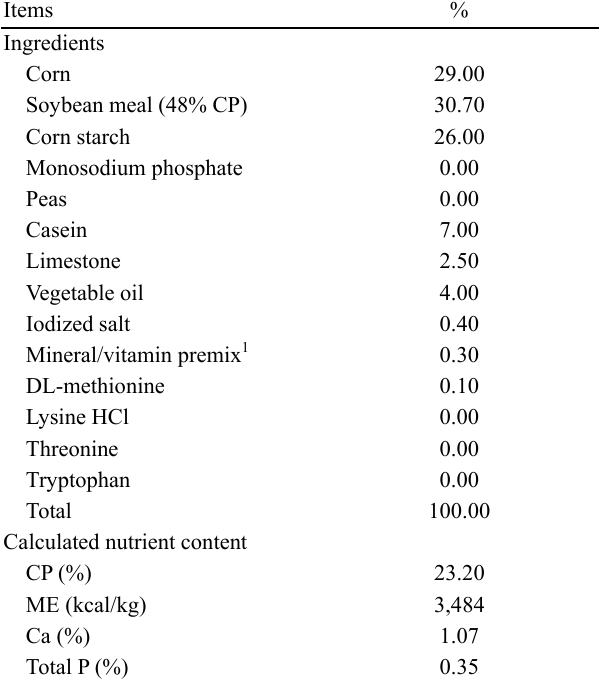
Table 1. Composition of the basal